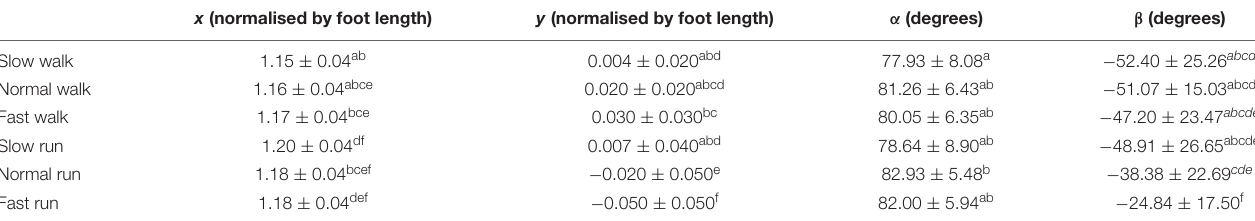
The value of mean ± SEM for all the trials across all the subjects were depicted. Different letters mean that the variable in a column differs significantly with each other (p < 0.05). TABLE 2 | Statistical analysis of the effect of the increasing speed from walking to running on the position and orientation of the functional axis (FA) of the MP joint. x (normalised by foot length) y (normalised by foot length) α (degrees) β (degrees) Slow walk